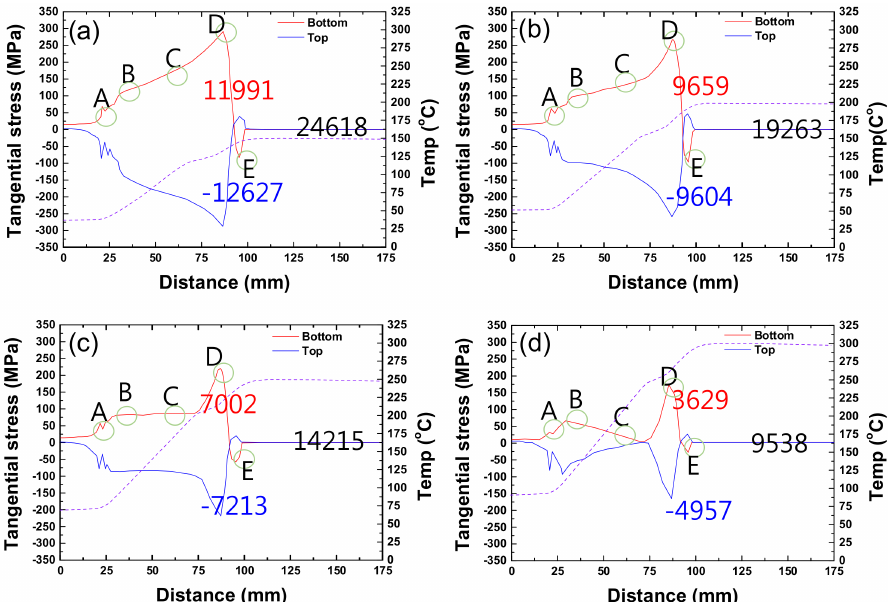
Figure 8. The tangential stress values in each distinct tooling region at the top and bottom layers of the blank (under non-isothermal condition) at ( a ) 150, ( b ) 200, ( c ) 250 and ( d ) 300 ◦ C. The dotted curves represent the temperature profile along the center of the cross-section of the sheet. For all cases, the punch speed was 1 mm/s.